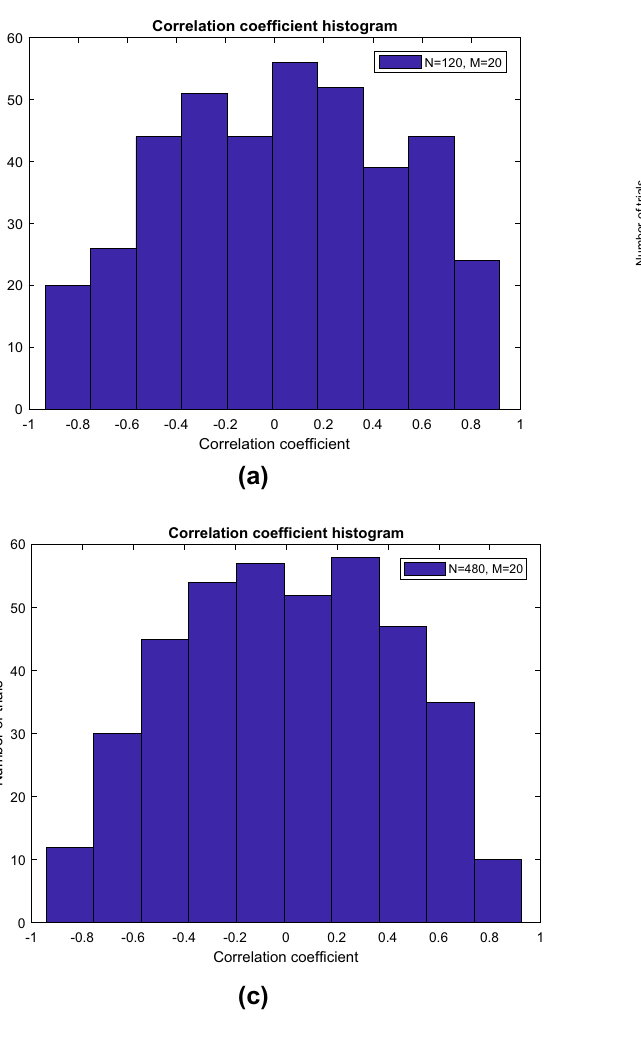
distributions are skewed towards − 1 or 1, but remain relatively uni- form over the whole interval, which indicates no reliable estimation